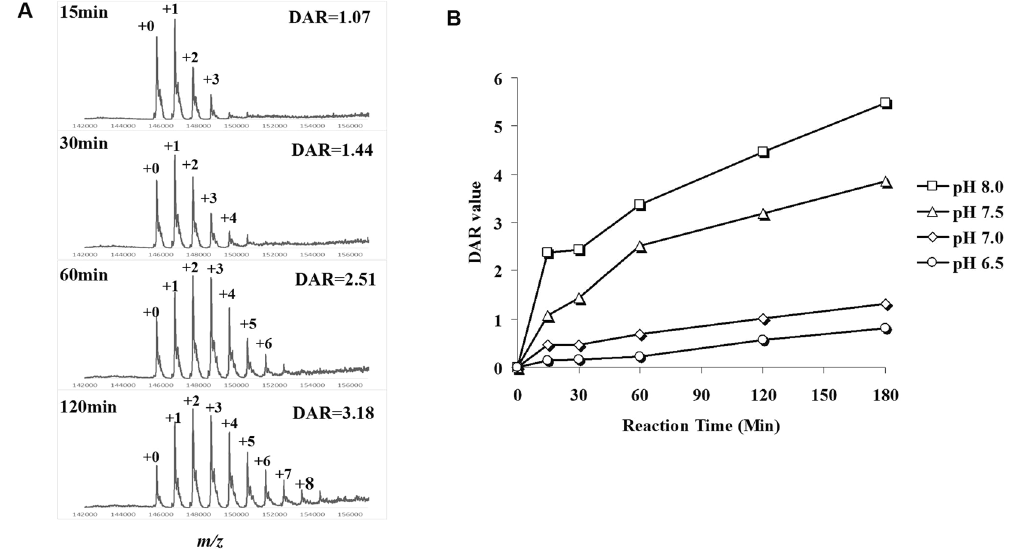
Figure 4. Real-time DAR detection of lysine-linked ADC for optimization of conjugation conditions. ( A ) representative LC-MS spectra of real-time DAR analysis on ADC 4 synthesized under pH 7.5; ( B ) real-time DAR analysis of ADC 4 synthesized under various pH